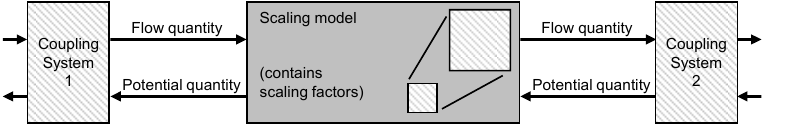
Figure 5. Integration of the scaling model via virtual coupling to adapt the mechanical quantities. [14].